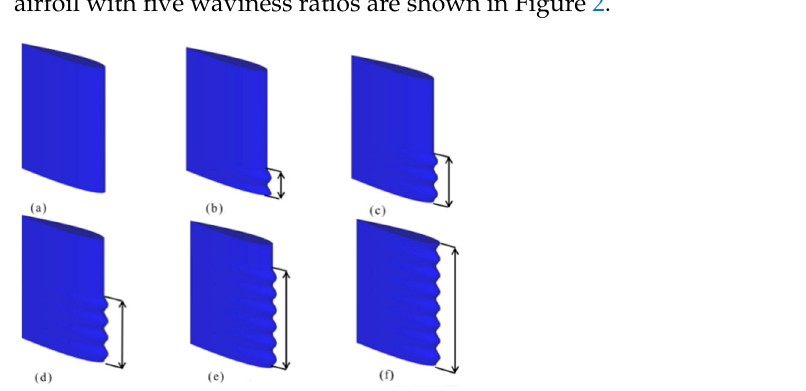
Figure 2. Airfoil models. ( a ) Baseline; ( b ) R = 0.2; ( c ) R = 0.4; ( d ) R = 0.6; ( e ) R = 0.8; ( f ) R =